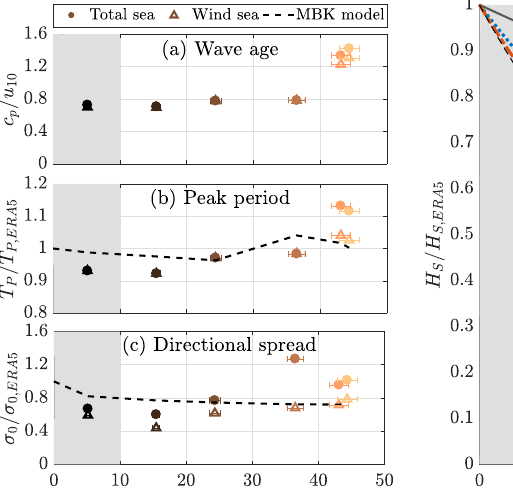
derived by applying the MBK model 21 to corresponding ERA5 spectra at the ice edge. d The solid grey line denotes the best (exponential) fi t for the total sea, the dashed line for the wind sea (total sea without swell) and the dash-dotted line the wind sea without wind input over ice. The thin dashed line is the benchmark attenuation derived for i c >0.8 and T P <14s 18